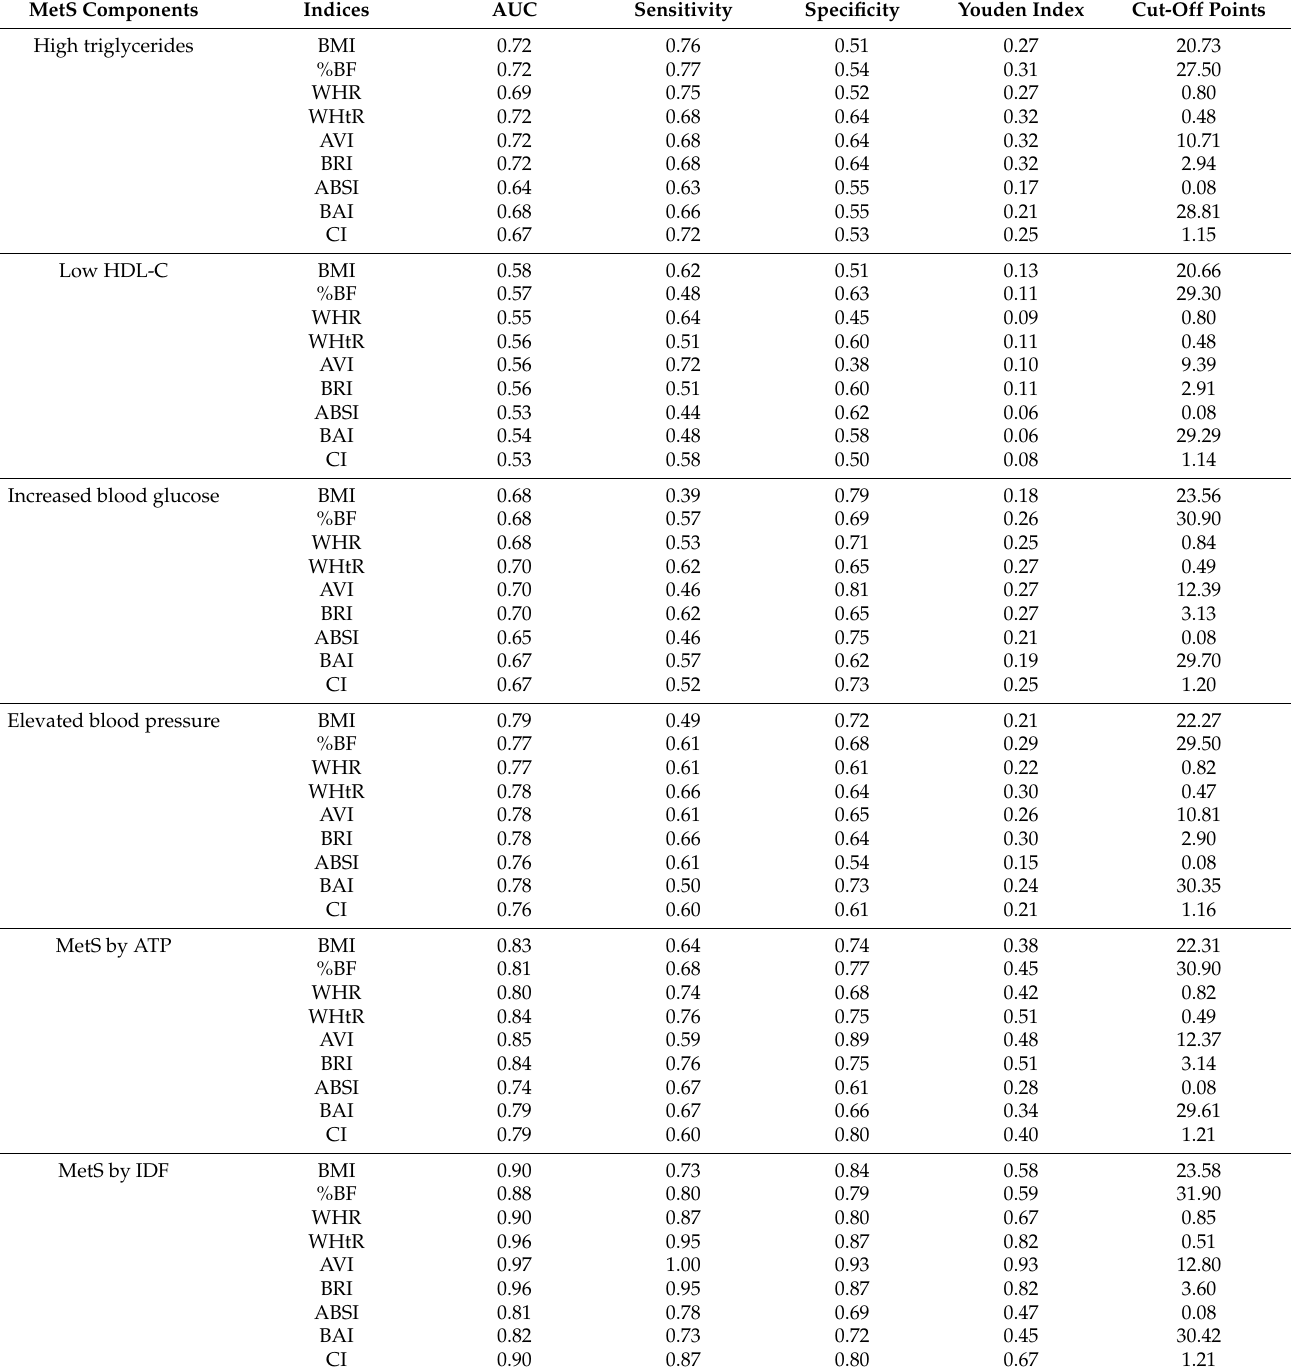
Table 4. Areas under the curve (AUCs) and cut-off points for anthropometric indices for the prediction of MetS components in